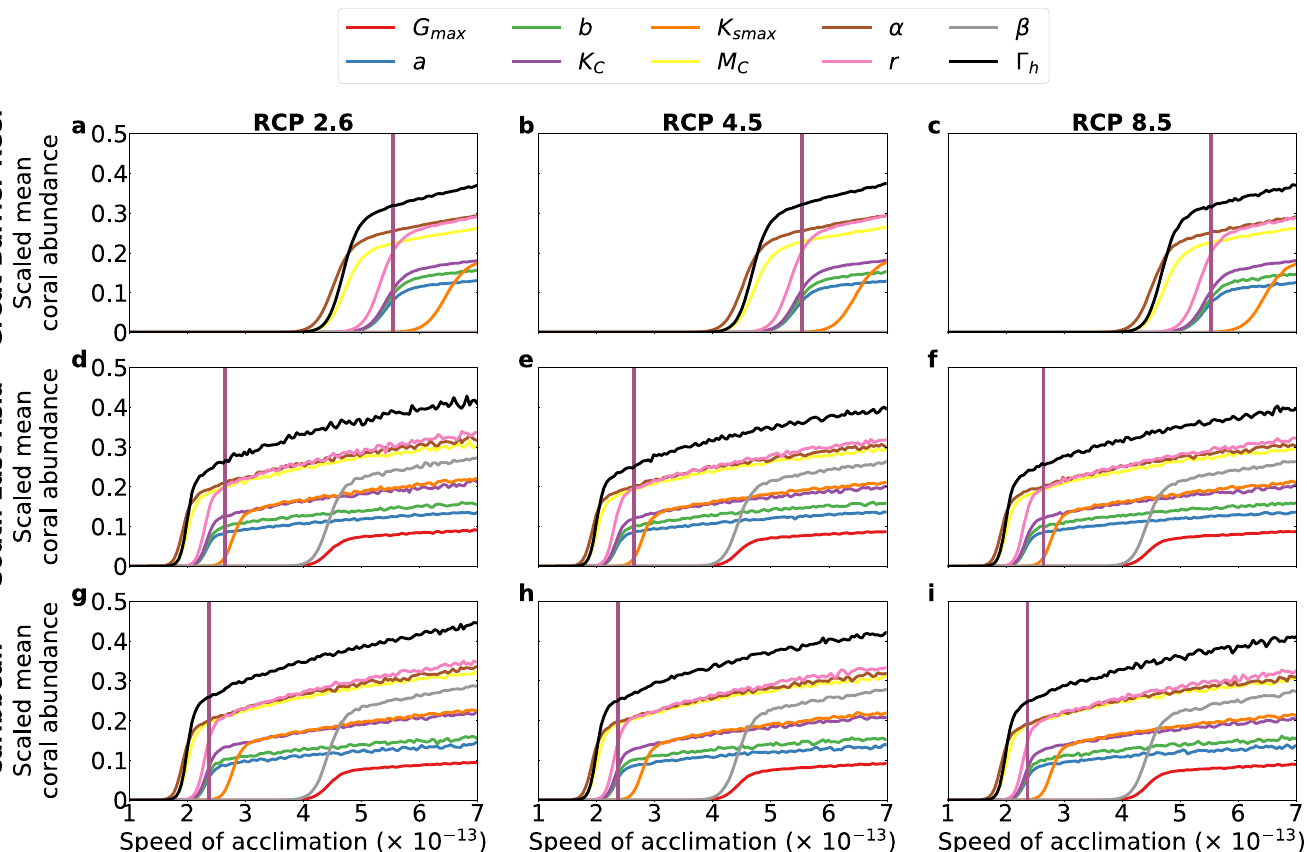
Fig 6. Sensitivity to speed of acclimation N for − 25% change in each parameter. Simulations with bleaching. Vertical lines mark the speed of acclimation we estimated from coral cover data (see S2 Appendix).